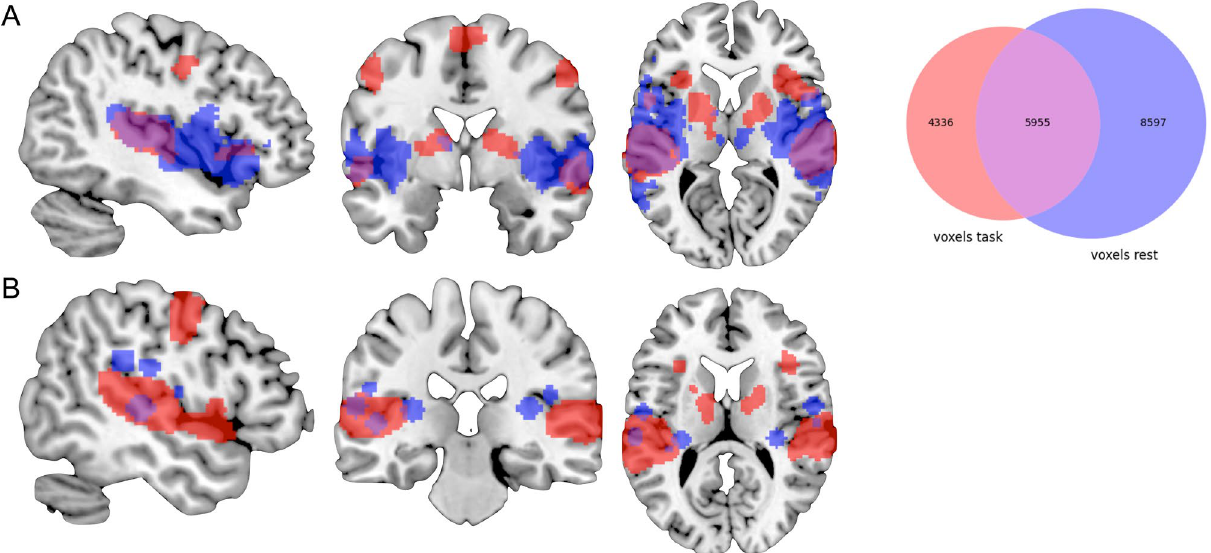
Figure 7. Overlap between the task-based (red) and resting-state-derived (blue) auditory networks by ( A ) Smith et al. 17 and ( B ) Power et al. 29 . For Power et al.’s graph nodes spheres of 6 mm were added for illustrative purposes. The Venn diagram on the right illustrates the number of voxels either network as well as the overlap in between these networks comprises. Brain networks were rendered on the individual anatomical template (“ch2better”) provided with MRIcron 25 . The Venn diagram was created using the Python package Matplotlib-